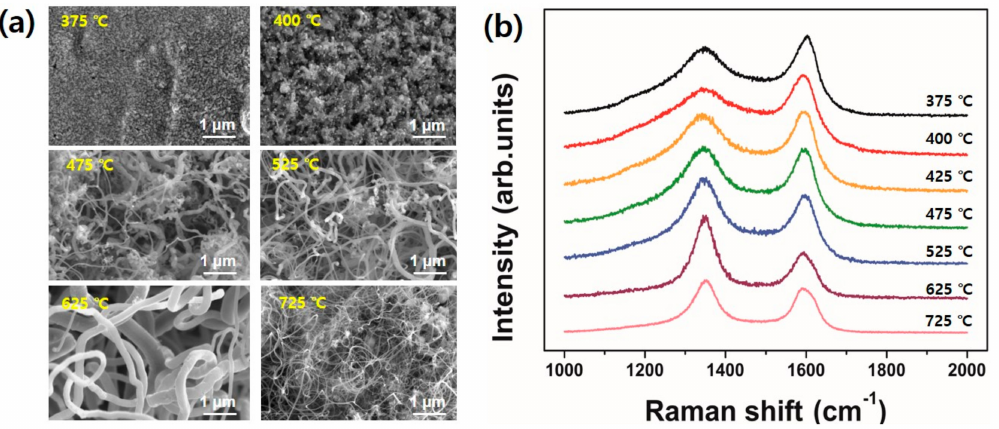
Figure 5. ( a ) SEM images showing the di ff erent morphologies of carbon nanotubes (CNTs) grown at specified temperature. The plasma power was kept at 10.5 W; ( b ) Raman spectra of the CNT samples in